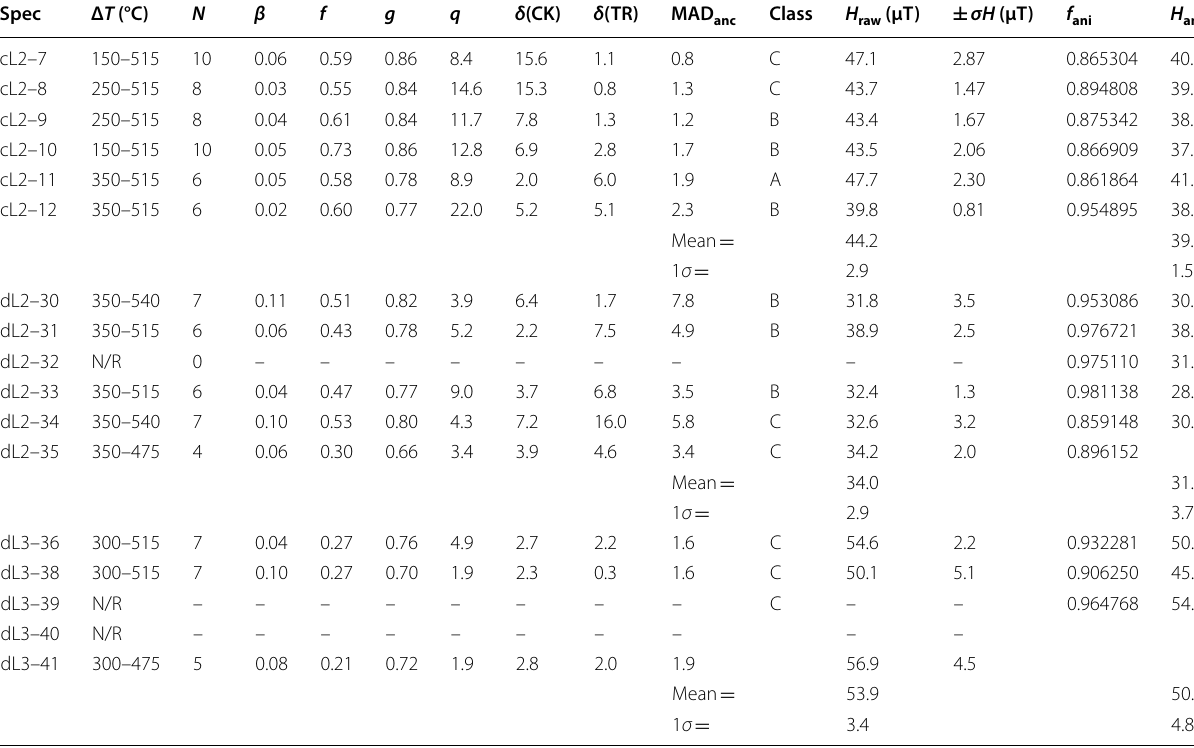
Table 4 Thellier–Coe paleointensity results for ceramic